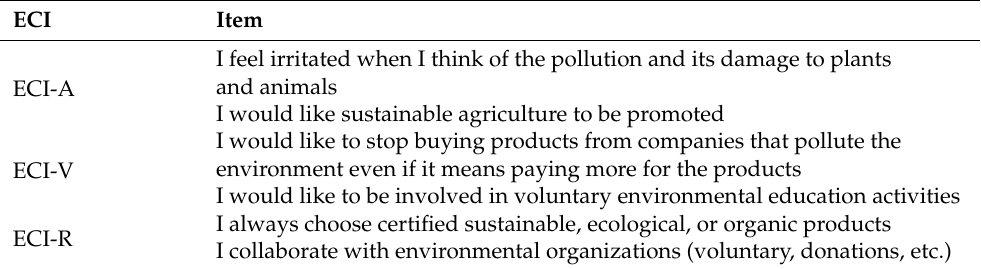
Table 1. Environmental Commitment Index (ECI)